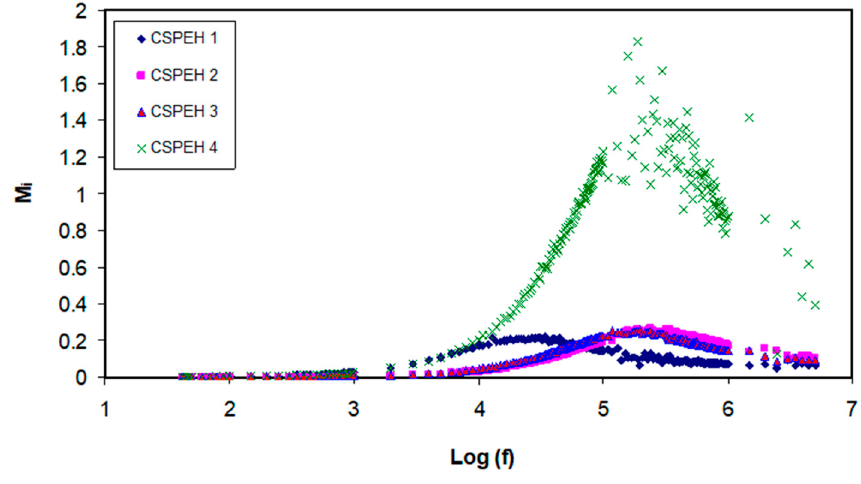
Figure 9. Electric modulus (M i ) imaginary part in opposition to the frequency logarithmic scale for all the electrolytes.